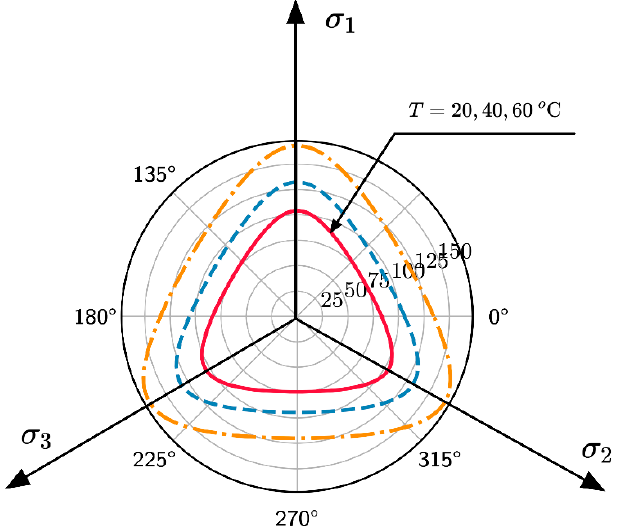
Figure 2. Matsuoka–Nakai criteria in the principal stress space with different temperatures.